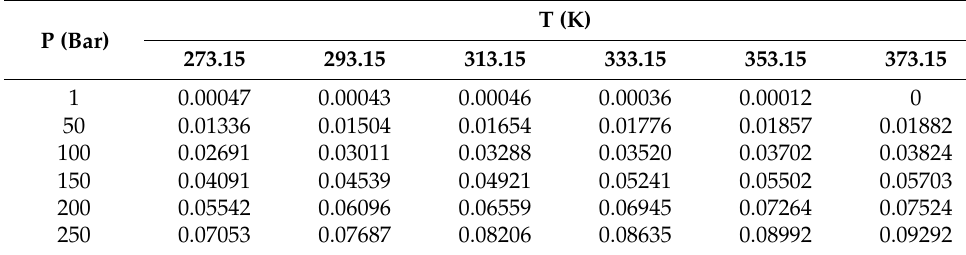
Table 6. Calculated H 2 solubility (mol/kg) in a 3 mol/kg NaCl solution.